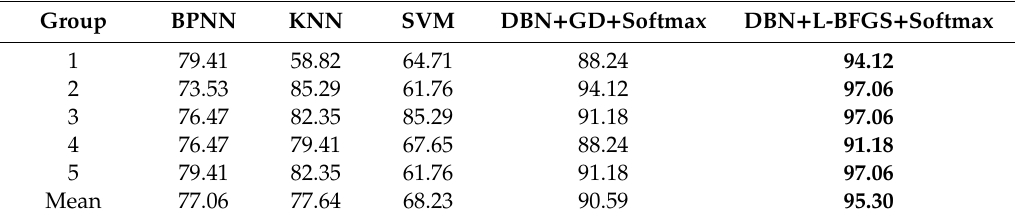
Table 1. Accuracies of classification in the positive spectrum data in the five-fold cross-validation experiment